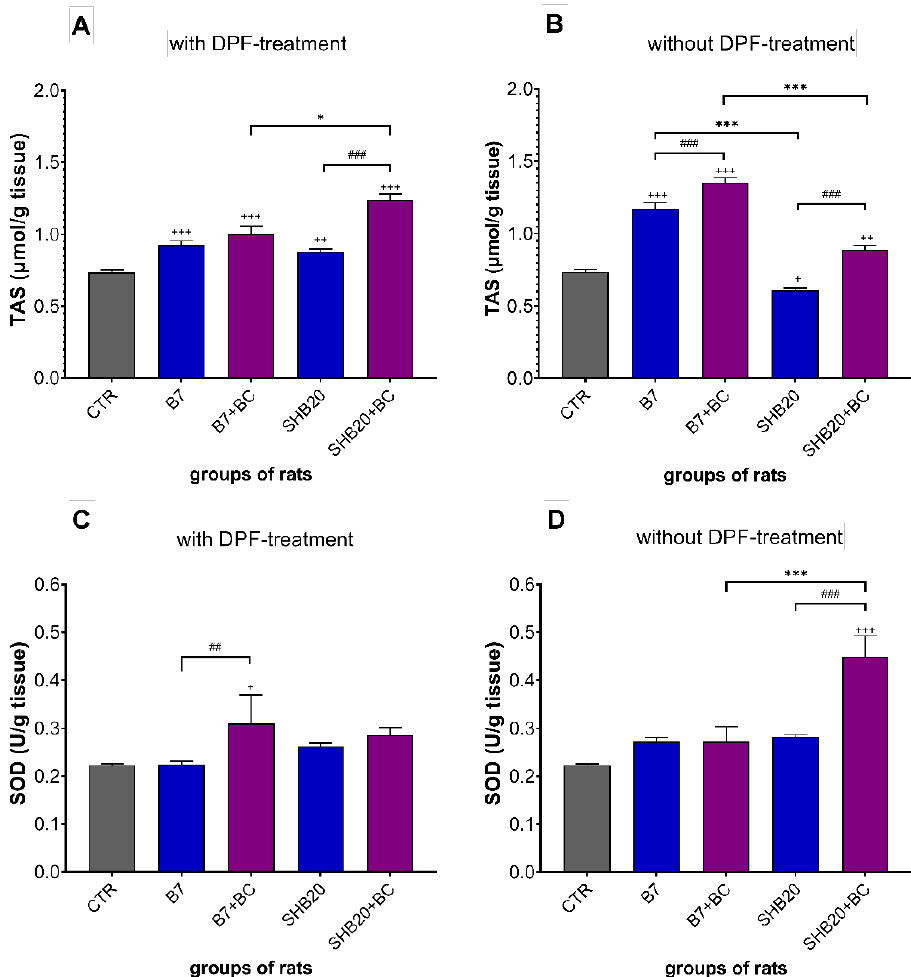
Figure 7. The total antioxidant status (TAS) ( A , B ) and superoxide dismutase (SOD) activity ( C , D ) in the testes of rats exposed to DEE from B7 and SHB20 biofuels with or without DPF-treatment and with or without blackcurrant pomace supplementation (BC) for 28 days. Data are expressed as mean ± SEM. # — Statistically significant difference between normal and blackcurrant pomace supplemented diet, ## p < 0.01; ### p < 0.001; * — Statistically significant difference between B7 and SHB20 DEE, * p < 0.05; *** p < 0.001; + — Statistically significant difference from the control group (CTR), + p < 0.05; ++ p < 0.01; +++ p < 0.001, one-way ANOVA with Duncan’s post hoc test.